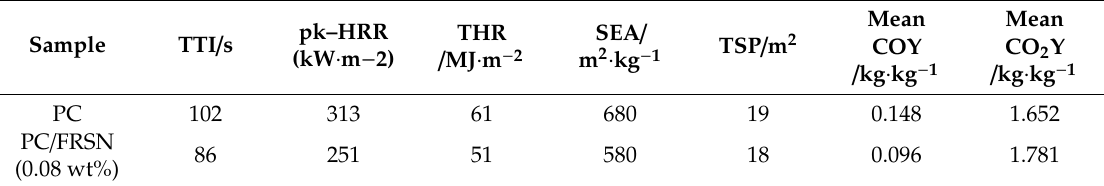
Table 2. Cone calorimetric data with heat flux of 35 kW · m −